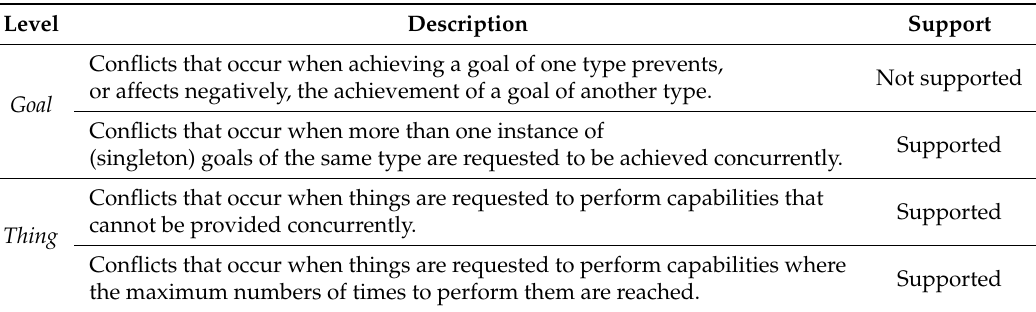
Table 1. The types of conflicts among ECs.